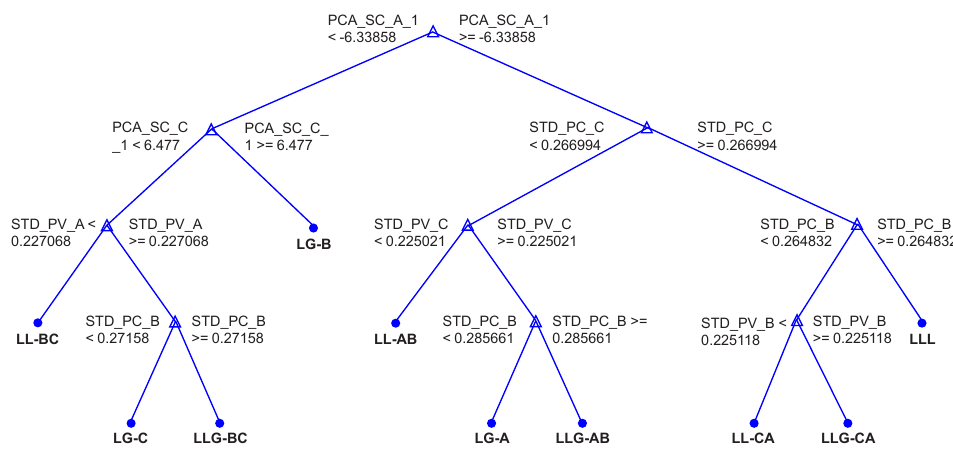
Figure 21. View of 20th Tree with 9 braches and 19